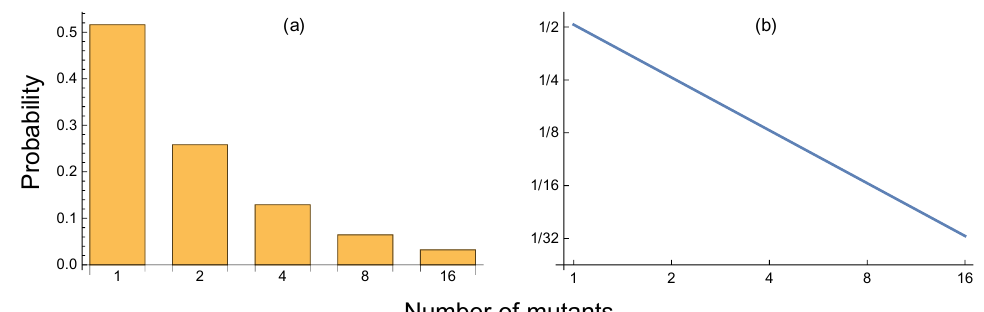
Figure 2. The probability of observing a particular number of mutants in the final population. ( a ) Probability declines by 1/2 for each doubling in the number of mutants in the final population. ( b ) A log–log plot of probability versus mutant number has a slope of minus one. This example follows from a discrete binary pattern of cellular division with a single mutational event, as in Figure 1. The actual log–log slope for a Luria–Delbrück process is approximately − ( 1 + e /2 ) ≈ − 2.36 (from Equation (5)). Part of the increase arises because multiple mutational events cause a more rapid decline at the extreme of the earliest mutations and greatest final mutant